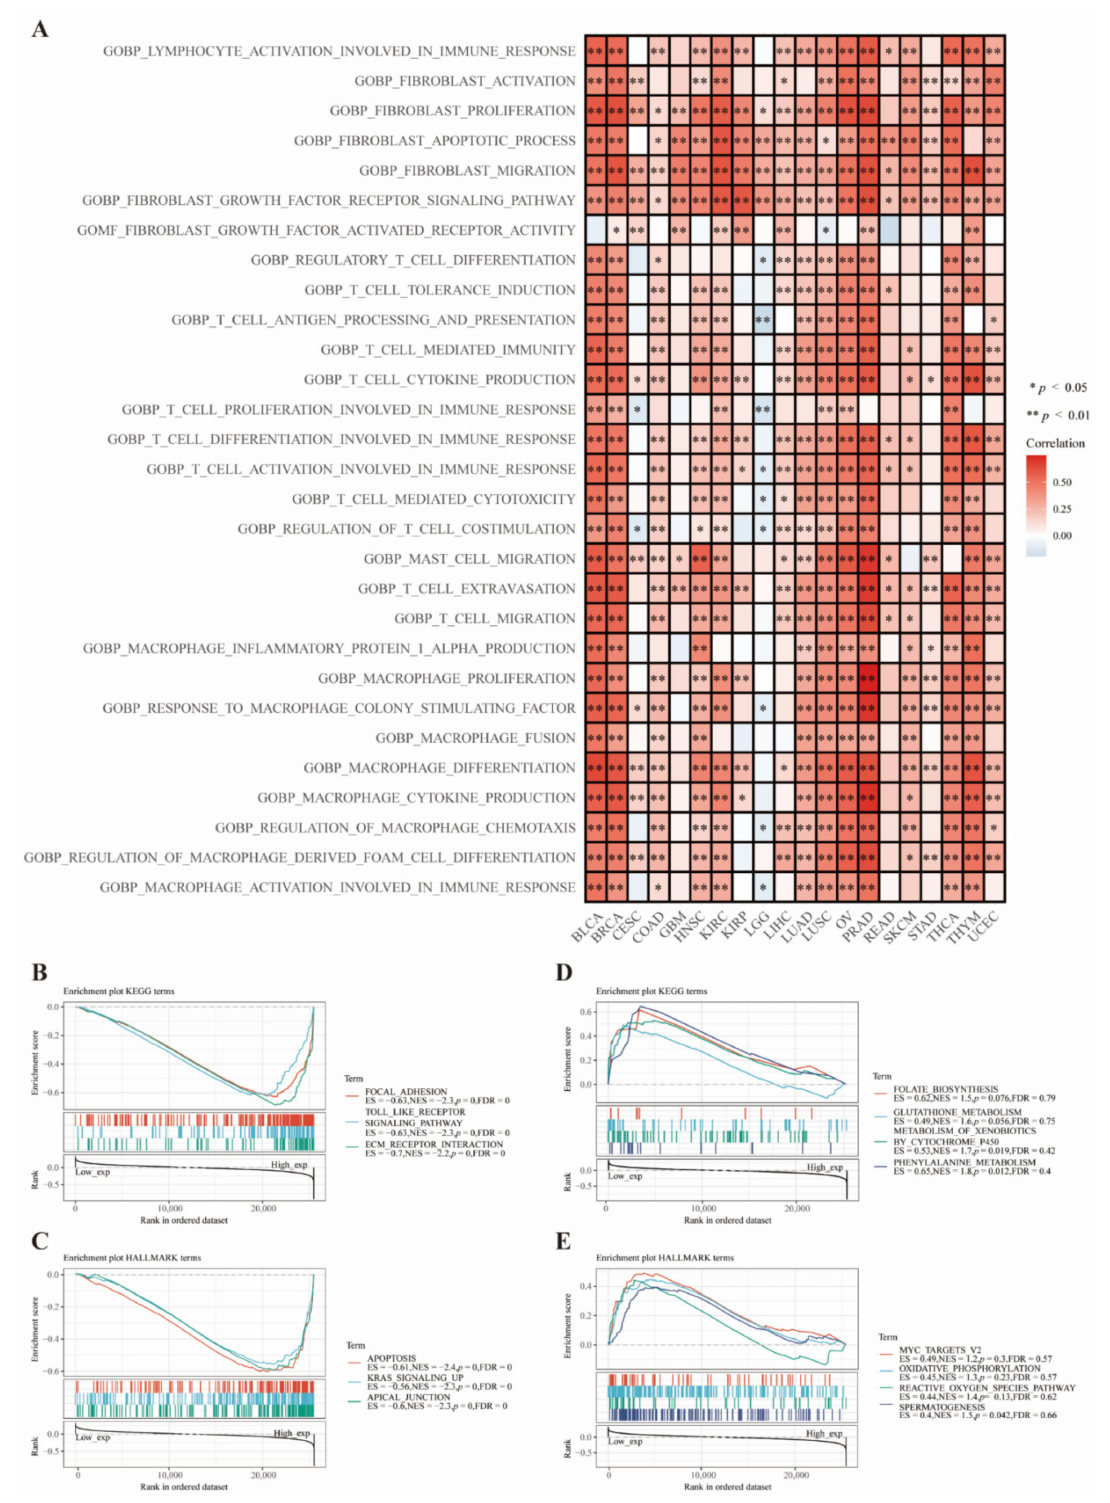
Figure 4. Functional enrichment pathways analysis of CD73. Enriched signaling pathways of CD73 from the GSVA algorithm ( A ). Top three negative ( B ) and top four positive ( D ) enriched KEGG terms of CD73. Top three negative ( C ) and top four positive ( E ) enriched HALLMARK terms of